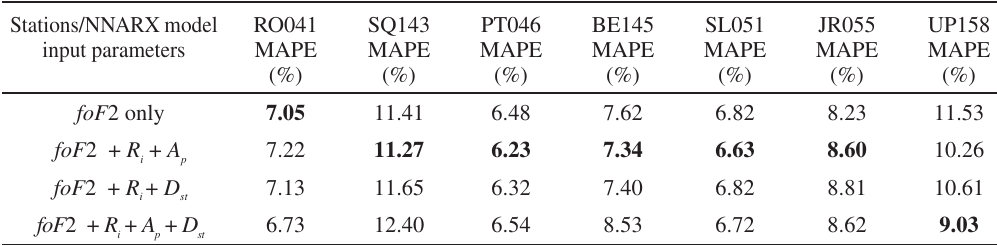
Stations/NNARX model input